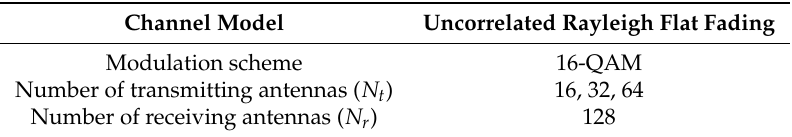
Table 2. Simulation